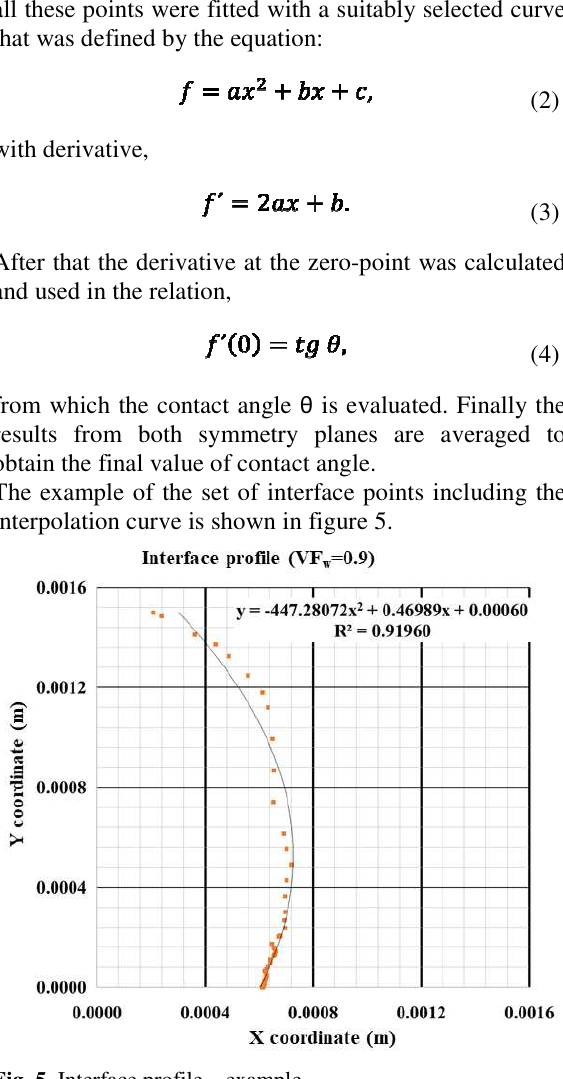
Fig. 5. Interface profile –